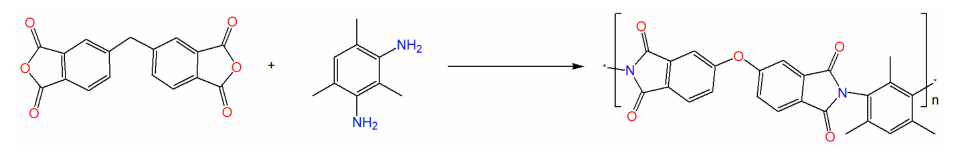
Figure 1. Reaction scheme of ODPA-TMPDA